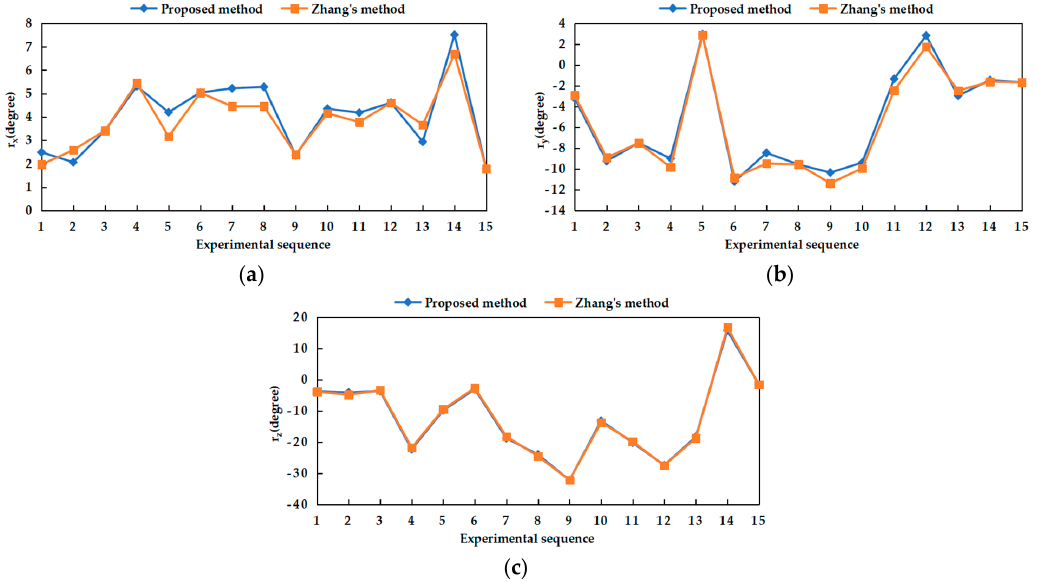
Figure 9. Euler angles between two cameras obtained by our proposed and Zhang’s methods: ( a ) r x obtained by two methods; ( b ) r y obtained by two methods; ( c ) r z obtained by two methods.